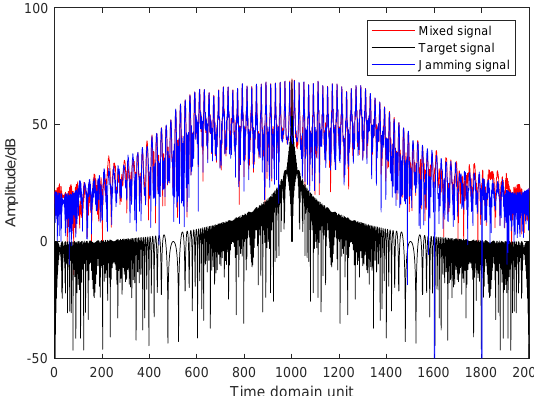
Figure 8. Pulse compression result of the output signal.